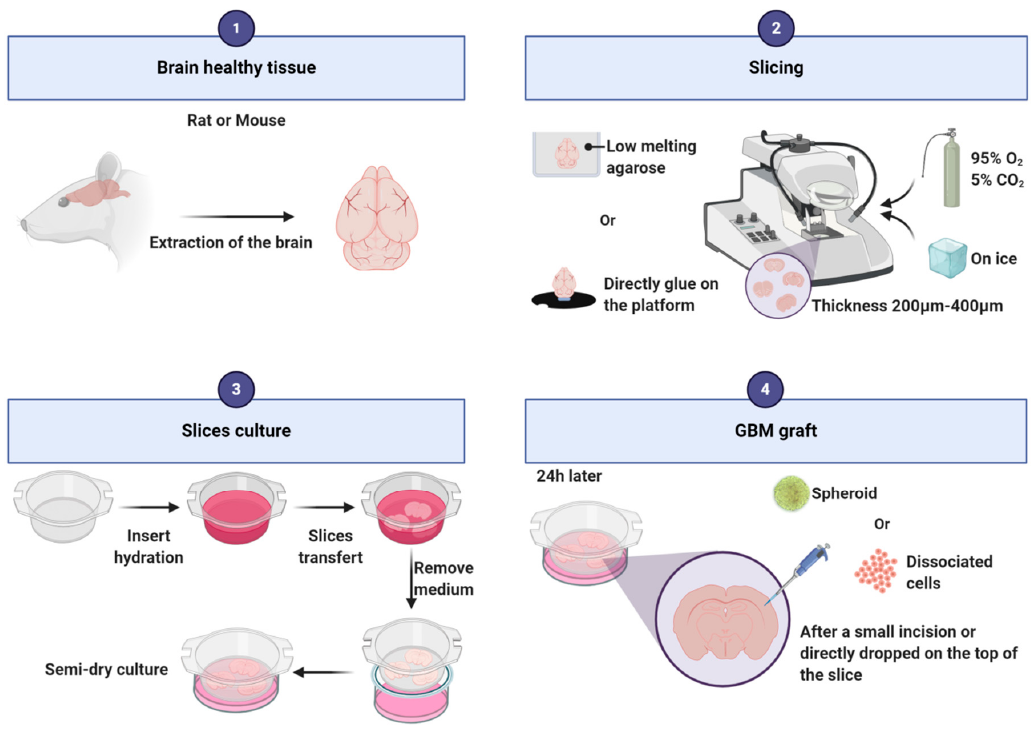
Figure 3. Main steps of the protocol for glioblastoma organotypic slice